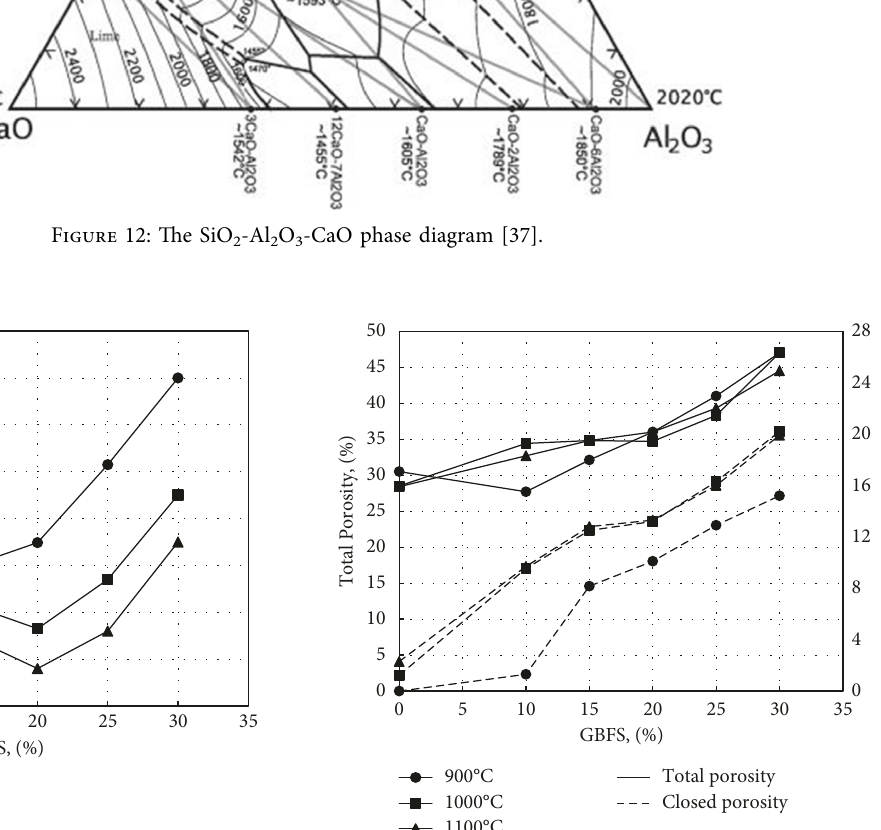
Figure 13: Effect of GBFS addition on apparent porosity.